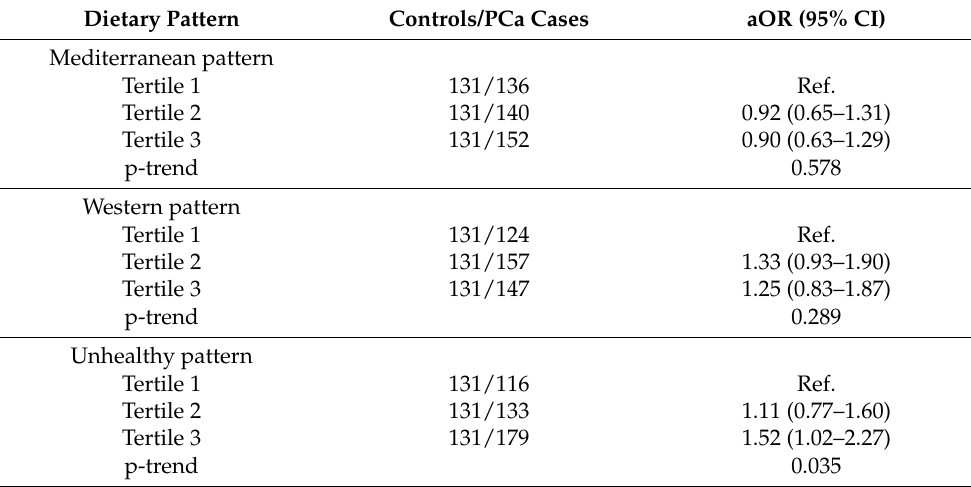
Table 3. Association between dietary patterns and PCa in the CAPLIFE study.